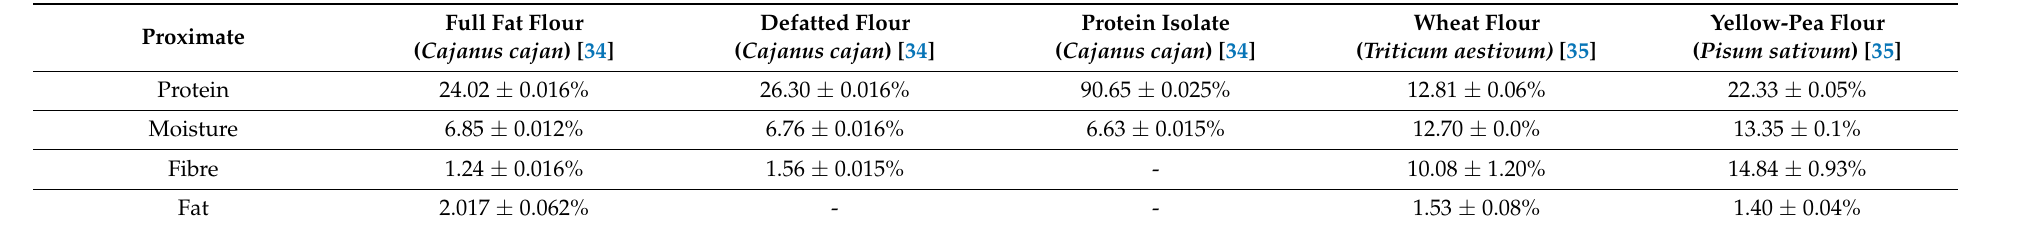
Table 3. Comparison of Cajanus cajan flour proximate composition with generally used